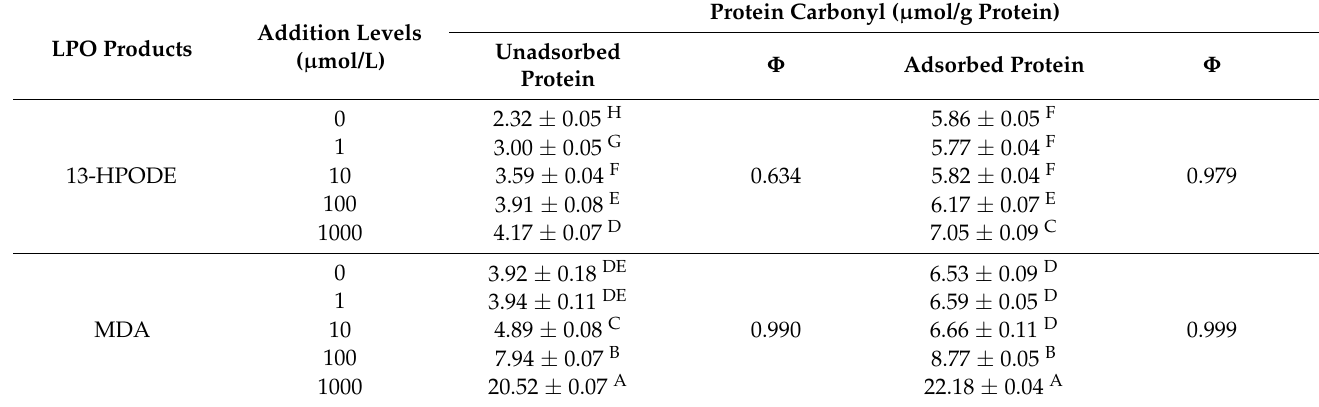
Table 3. Protein carbonyl levels of unadsorbed and adsorbed proteins extracted from the O/W emulsion oxidized by different levels of 13-HPODE or MDA for 24